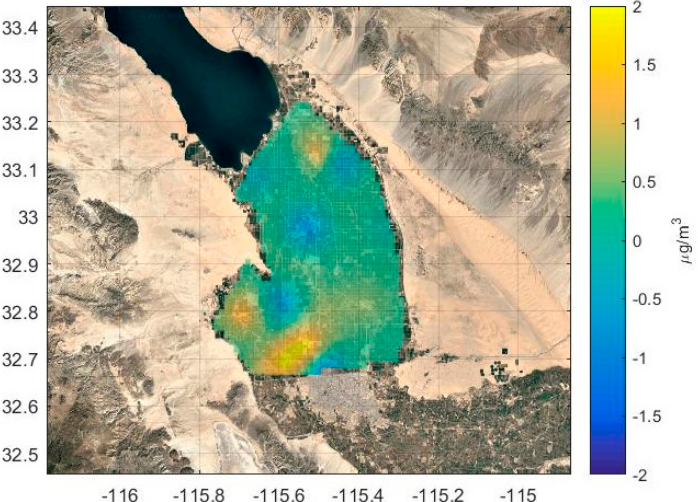
Figure 11. Map of residuals of annually averaged model minus measured concentrations. Map produced by Kriging residuals of model minus measured concentrations computed at IVAN receptors over the valley. See Section 3.3 for discussion.